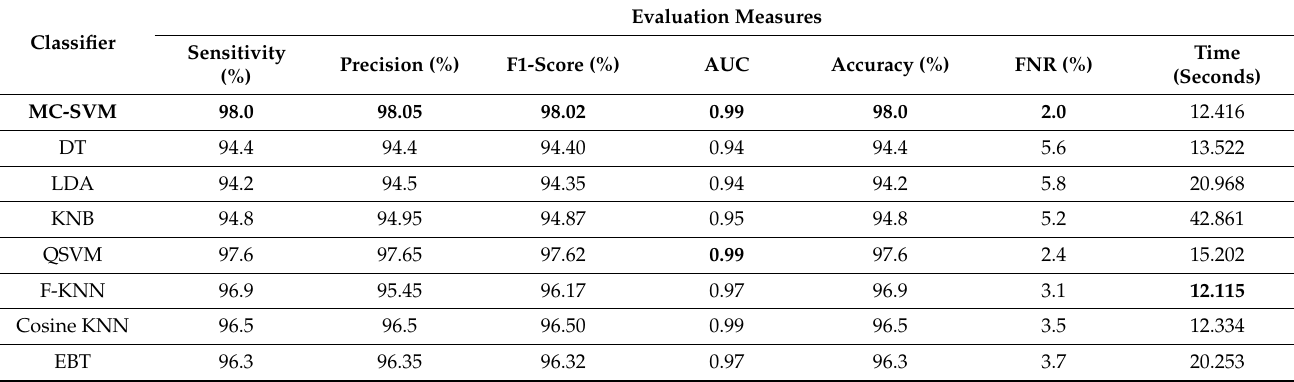
Table 1. Proposed COVID-19-infected classification results for the selected imaging database. Best values are shown in bold.